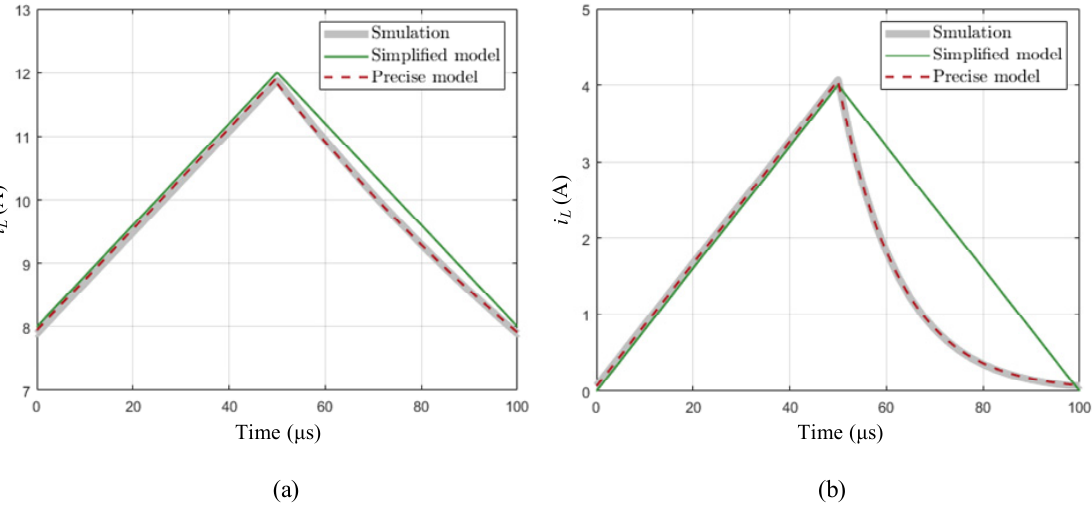
Figure 10. The comparison of the inductor current waveforms between simulations, the simplified model, and the precise model: ( a ) when R load = 10 Ω , and ( b ) R load = 100 Ω . The error of the inductor current ripple ∆ i L and the inductor average current I L solved by the proposed two models are shown in Figure 11, where I L * and ∆ i L * were solved by the simplified model, and I L and ∆ i L were solved by the precise model. As shown in Figure 11, the error between these two models increased with the increase of I L , and the error was positively correlated with R DS(on) . The error of I L and ∆ i L were both within 10% when R ds(on) was less than 500 m Ω and I L was less than 30 A. When the R ds(on) of the MOSFETs was smaller than one milliohm of resistance, the error of I L and ∆ i L were both less than 5%.